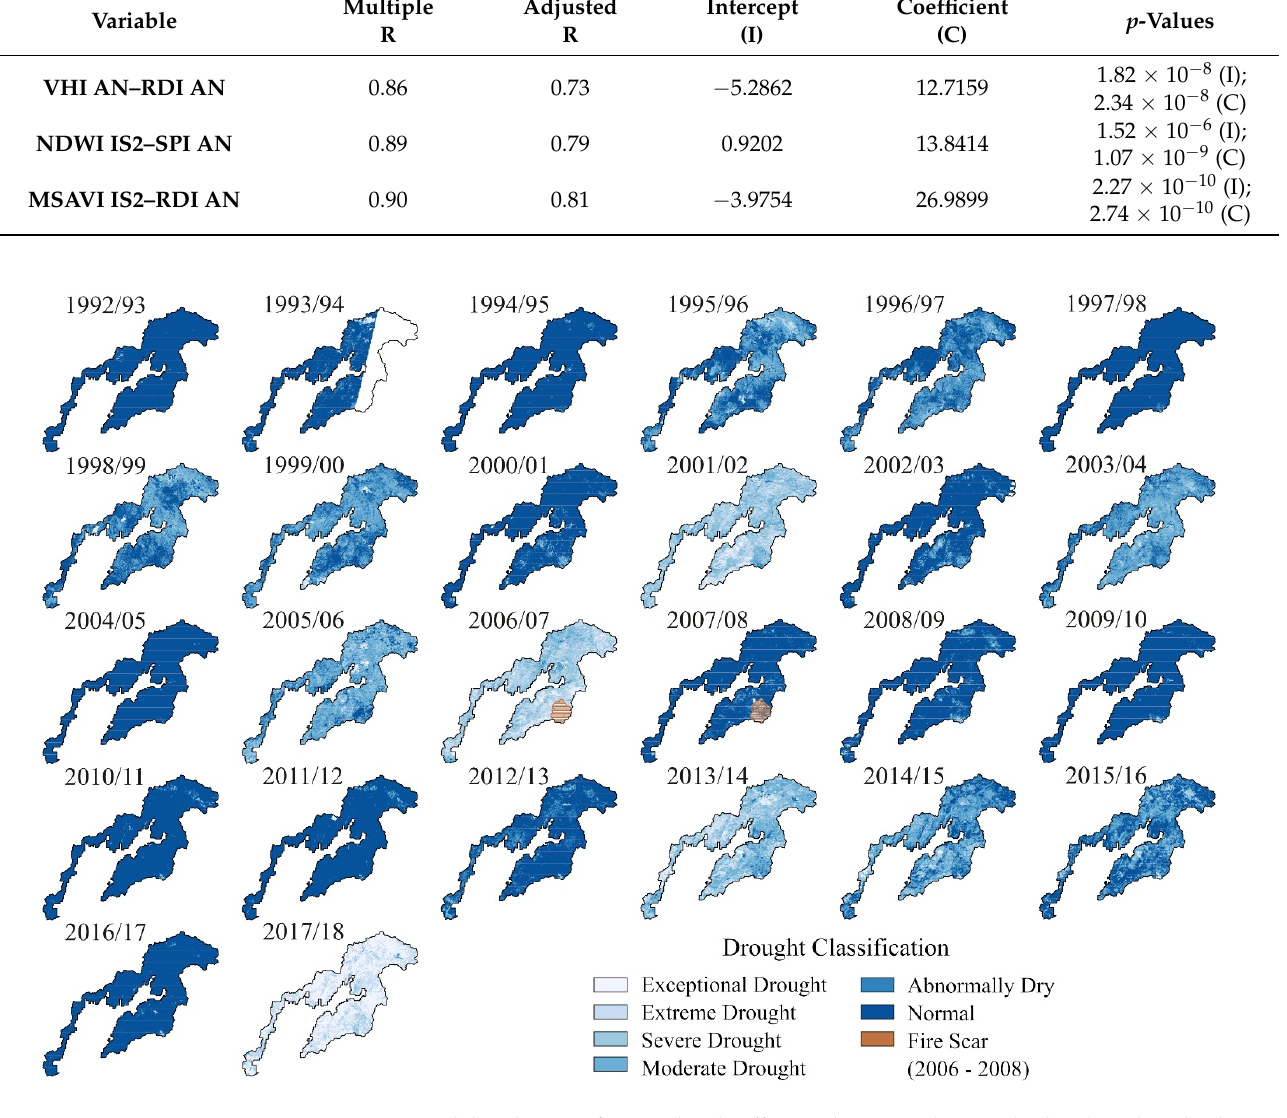
Figure 5. Spatial distribution of Normalized Differential Water Index standardized predicted values in the intervening season 2 (IS2) to classify annual drought severity and spatial extent from 1992/93 to 2017/18 hydrological years at the Guadalupe Valley Basin, Baja California, Mexico. During the 1993/94 hydrological year, there was a missed area due to incomplete Landsat 5 TM scene data.